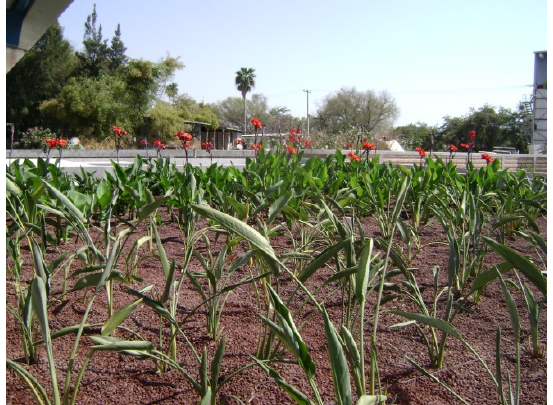
Figure 1 . Wastewater Treatment System (field